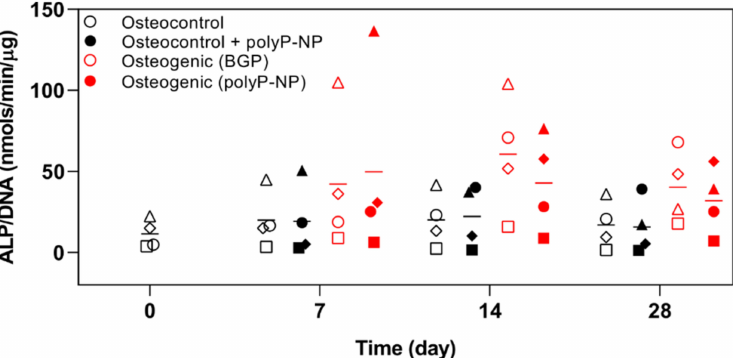
Figure 2. Alkaline Phosphatase (ALP) activity between treatment groups over time. Human BM-MSCs are cultured in osteocontrol media ± polyP-NP, or osteogenic medium containing either BGP or polyP-NP, for 7, 14 or 28 days. ALP activity in cell lysates is then determined and normalised to DNA content. Data are shown as the mean of two technical replicates for each individual donor: donor A ( (cid:3) ), donor B ( ∆ ), donor C ( ♦ ) and donor D (o). The mean of the four independent donors within each group is indicated by the horizontal